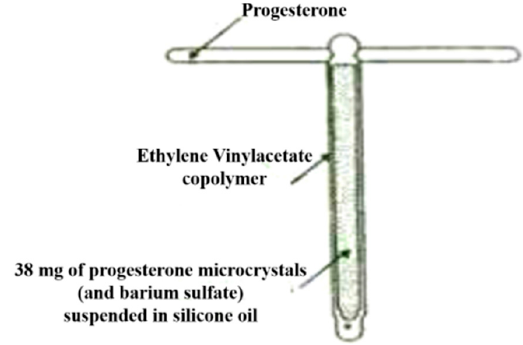
Figure 15. Progestasert IUD with structural components shown (adapted from [137]).